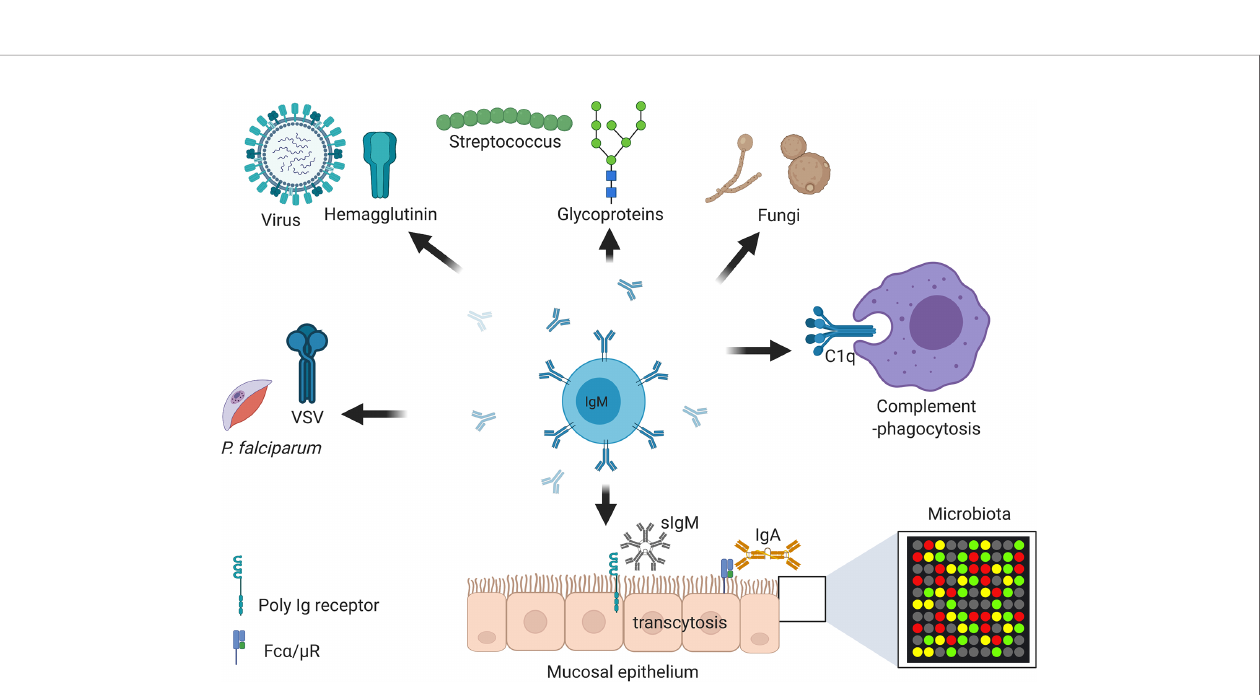
FIGURE 3 | Immunoglobulin M (IgM) is central at steady stage and against infections and non-communicable diseases. Secretory IgM is important at mucosal surfaces in maintenance of healthy microbiota together with secreted IgA. Secretory IgM together with IgM B cell receptor are important in initiation protective immunity against various respiratory pathogens including species of fungi, viruses, and bacteria. Secreted IgM is essential in parasitic infections including those causing malaria and sleeping sickness. Secreted IgM play an important part in cancers diagnosis and auto-immunity diseases such as systemic lupus erythematosus (SLE) and rheumatoid arthritis (RA). Secreted IgM has high af fi nity for C1q, a complement component that allows degradation of antibody coated pathogens and apoptotic debris. Created with